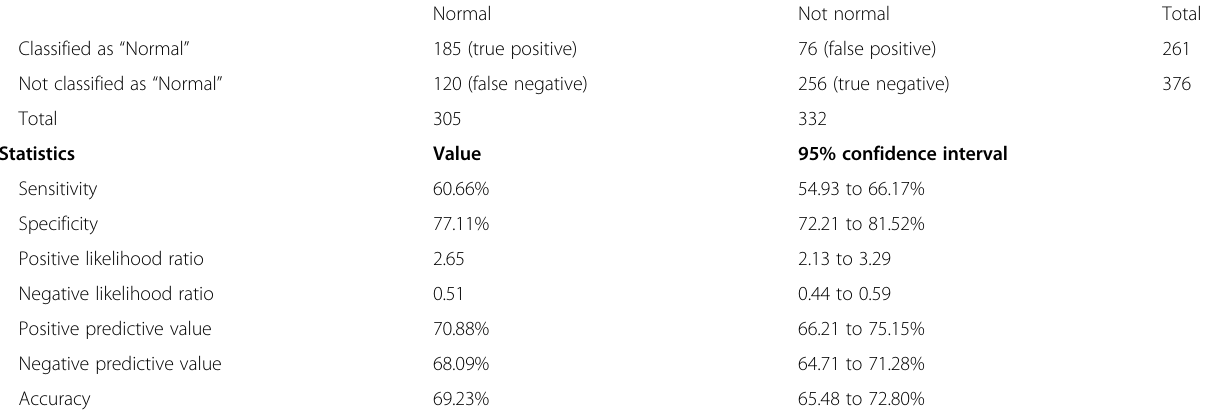
Table 2 Evaluation of model performance in detecting “ Normal ” chest radiographs